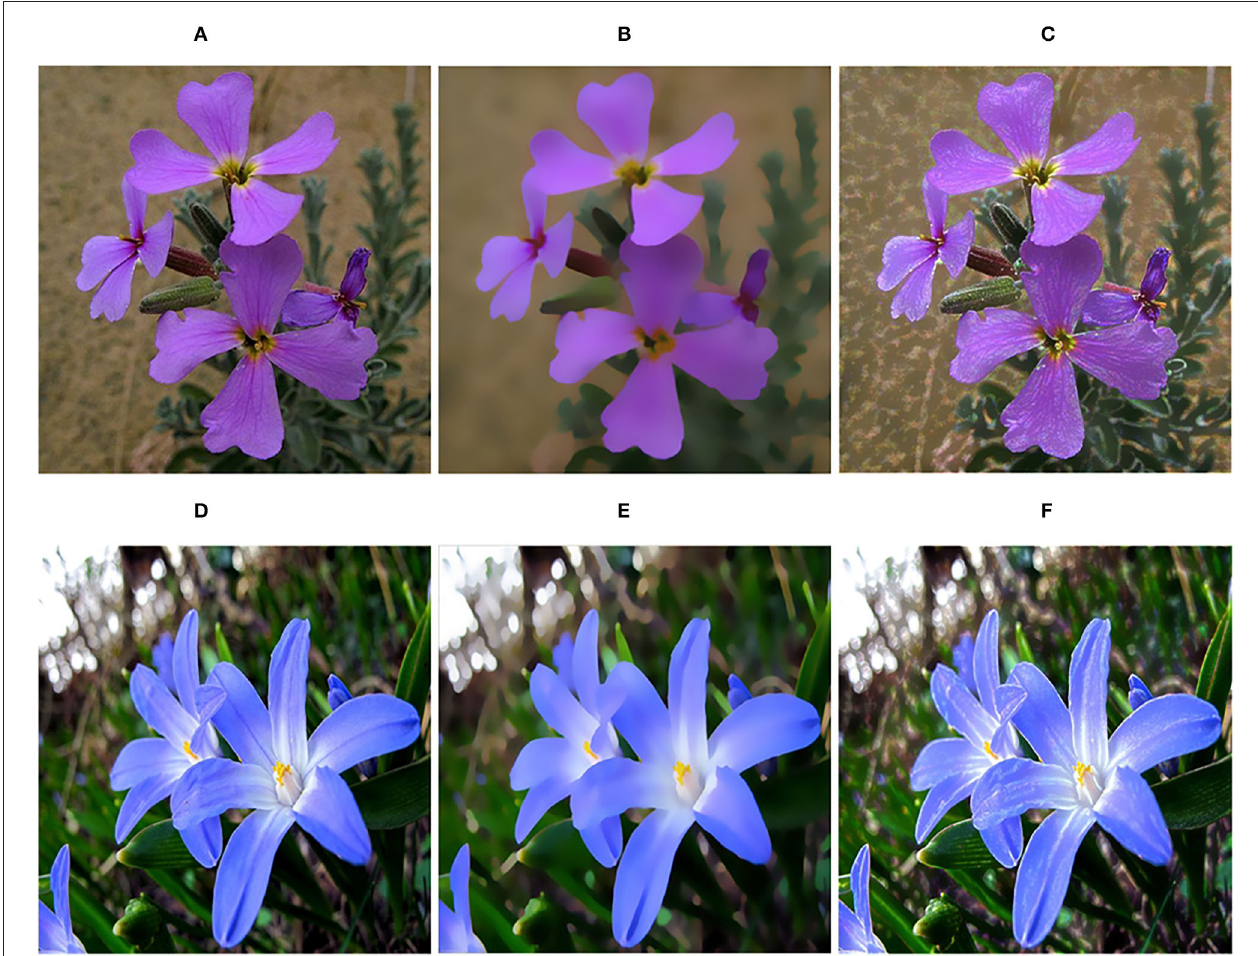
FIGURE 10 | Detail enhancement. (A,D) Input images; (B,E) Filtered results using our method; (C,F) The detail enhancement results. Reproduced with permission from Wei Liu, Pingping Zhang, Xiaogang Chen, Chunhua Shen and Xiaolin Huang, available at